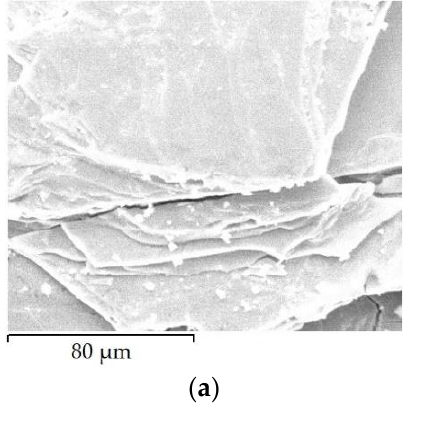
Figure 1. SEM image ( a ) and the EDX spectrum ( b ) of the In 2 O 3 layer formed on the surface of the InSe:Cd (0.5 at.%) plate.